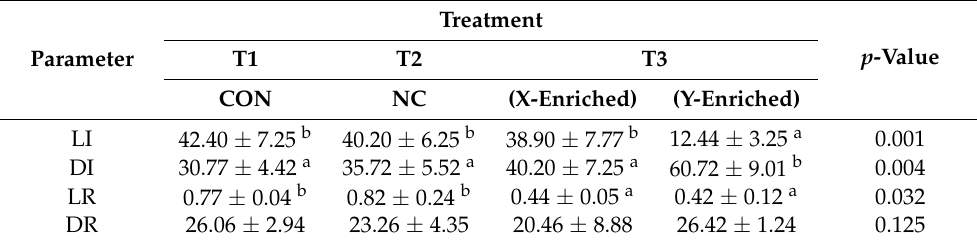
Table 4. Acrosome integrity of frozen–thawed sexed semen by PY-microbeads ( n = 20; mean ± SD).